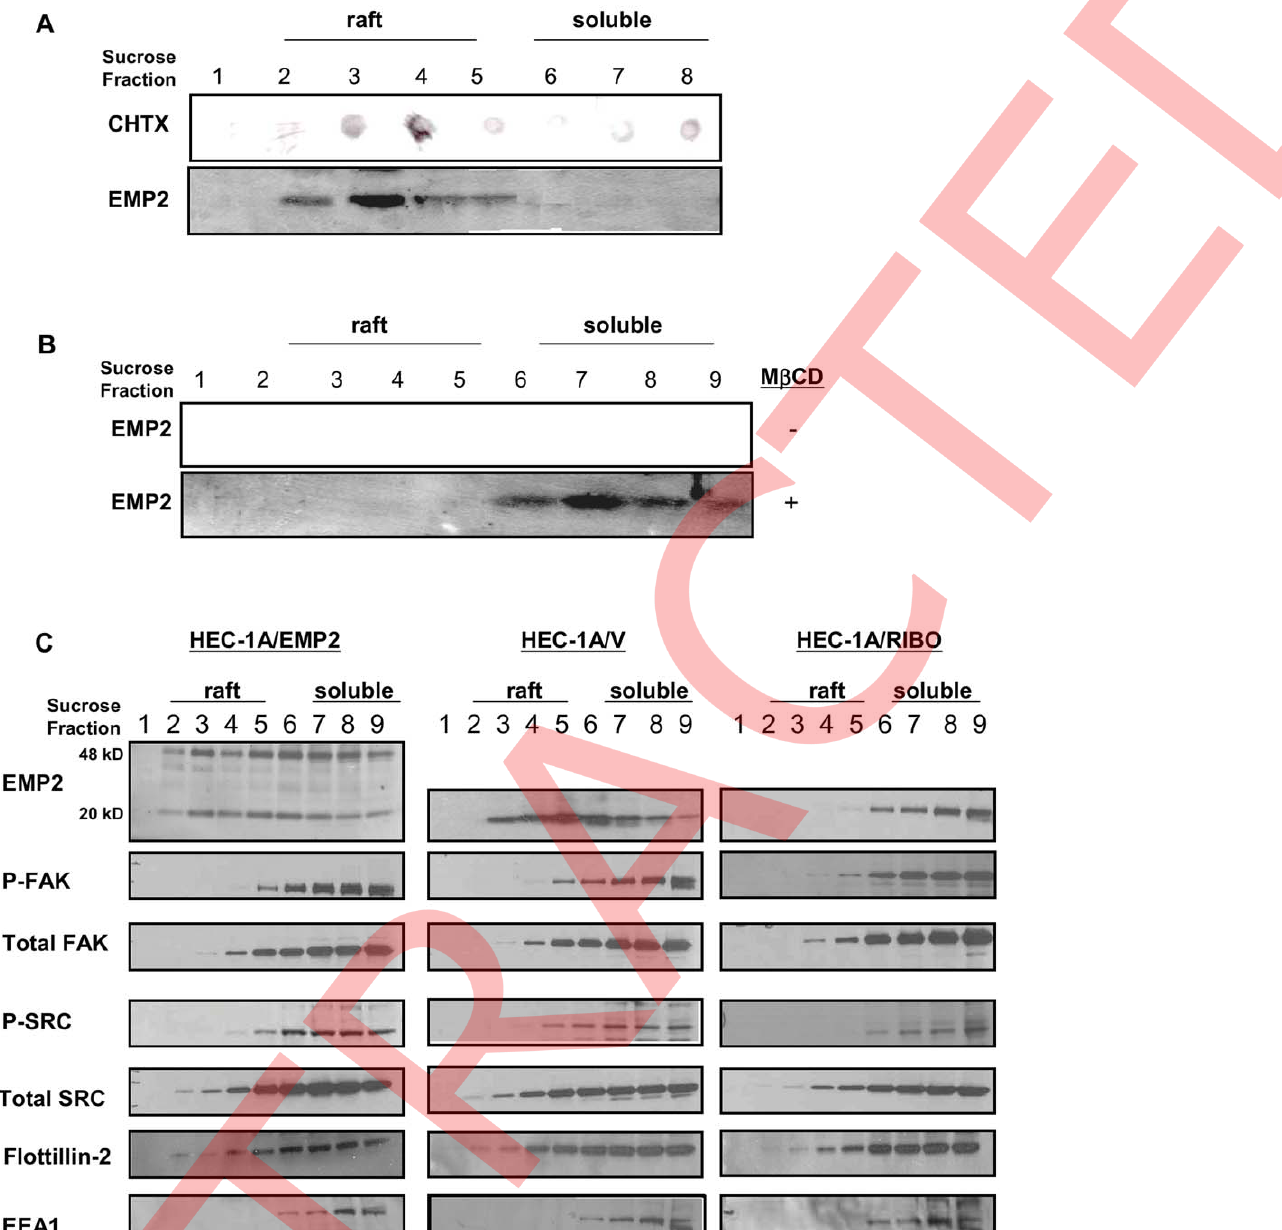
localization within lipid raft fractions (fractions 2–5) as well as in the 1% Triton X-100 detergent soluble fractions (fractions 6–9). In contrast, decreased levels of total FAK and Src were present in lipid raft fractions in HEC-1A/RIBO cells. Similar results were observed with the activated forms of these proteins. Upregulation of EMP2 expression resulted in increased localization of activated